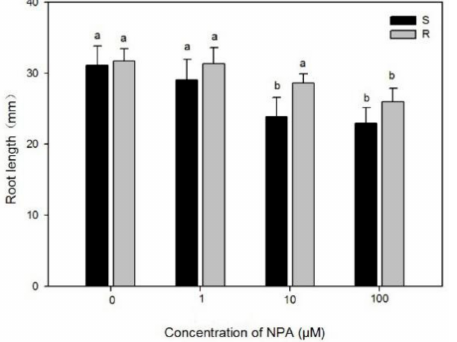
Figure 2. Root length of two biotypes at 7 days after treatment with 0 µ M, 1 µ M, 10 µ M and 100 µ M 1-N-naphthylthalamic acid (NPA). S represents the susceptible biotypes (JNNX-S), and R represents the resistant biotypes (SSXB-R). Data are the mean values of at least 10 biological replicates. The standard errors of the means are described by vertical bars. ANOVA significance groupings are shown as a and